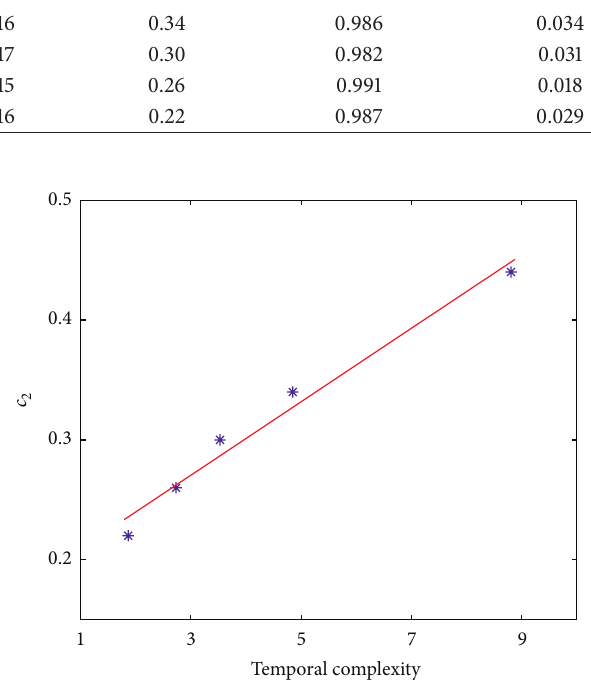
Figure 8: Relationship between temporal complexities 𝛿 𝑡 and 𝑐 2